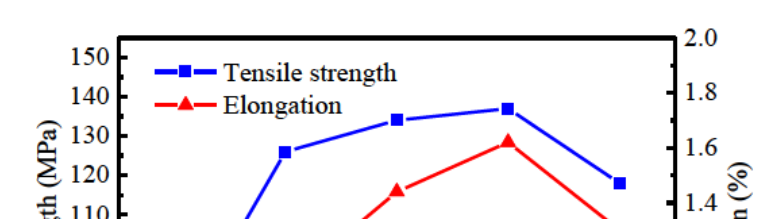
The incompatible deformation appeared at the Al/Mg join- ing interface because of the hard and brittle IMCs during the bigger tensile load, which easily leaded to the stress concentration and the initiation of the cracks. In this study, the interfacial joining length of the RS was bigger than that of the AS, thereby resulting in the joint fracture at the joining interface between the SZ and the TMAZ of AS (Figure 9d). As the welding speed further increased to 70 mm/min, the fracture location occurred at the cavity de- fect (Figure 9e). Therefore, the welding defects induced by the adhesion phenomenon and the reduction of heat input were the prominent reason of the joint fracture, while the IMCs layer was the main factor for the sound joint.